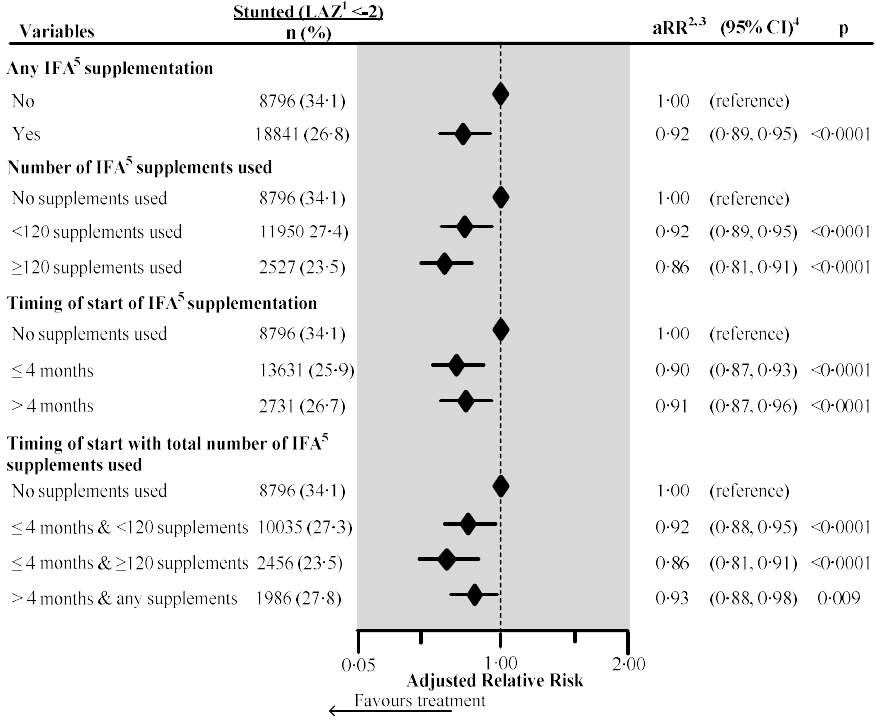
Figure 1. Effect of any iron/folic acid (IFA) supplementation, the number of supplements used, the Figure 1. E ff ect of any iron / folic acid (IFA) supplementation, the number of supplements